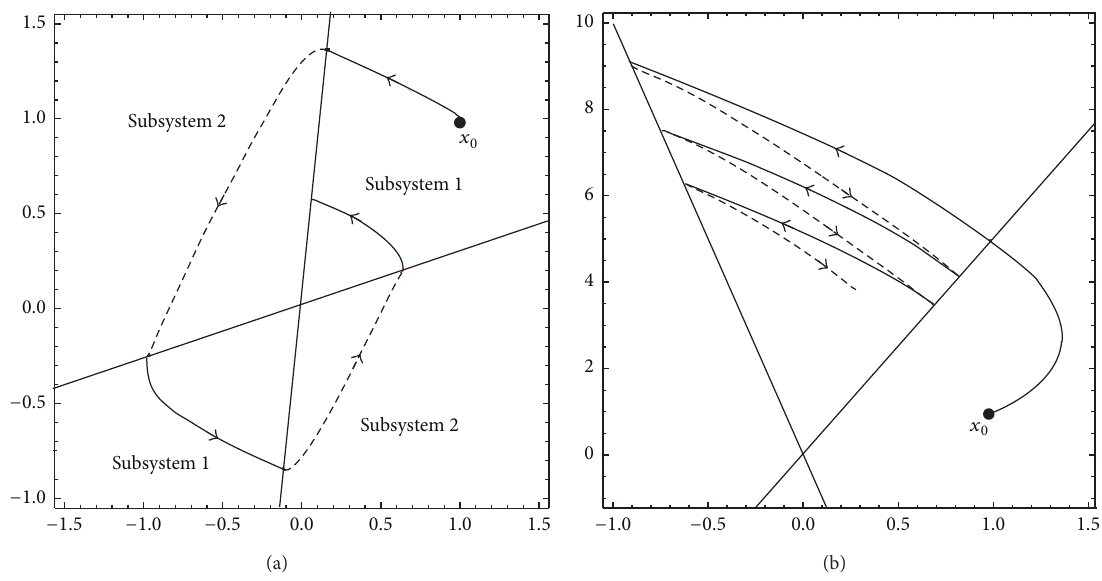
Figure 3: Solution and rays given by 𝐹(𝑥) = 0 in Example 1 (a) and Example 2